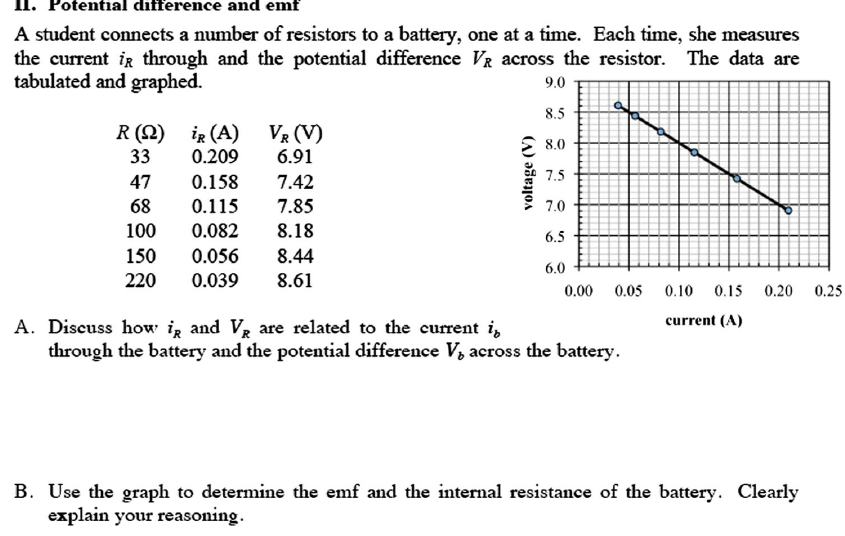
FIG. 3. Activity designed to help students to understand that emf and potential difference are different concepts. Students are guided to pay attention to the constant value of the emf of the battery and the dependence of the value of the potential difference on the circuit topology and the current.